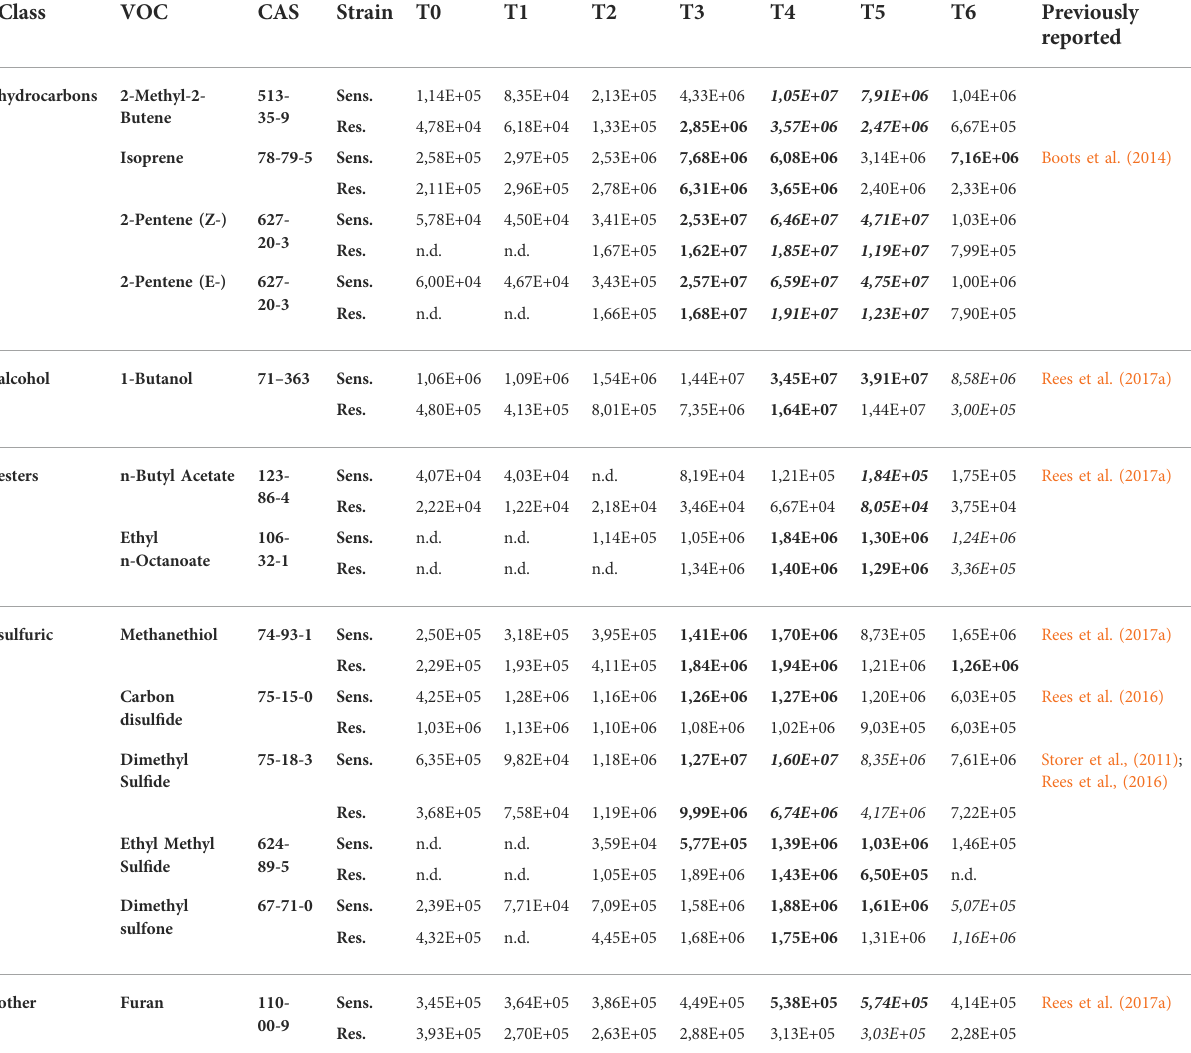
Tablelegend: Sens .,asensitivestrainofKPN; Res .,aresistantstrainofKPN; boldvalueofpeakarea ,indicatesthestatisticallysigni fi cantdifference(Kruskal-Wallistest)betweenthetimepointof interest and T0. Underlined italic value of peak area , indicates the statistically signi fi cant difference (U-Mann-Whitney test) between resistant and sensitive strain at the same